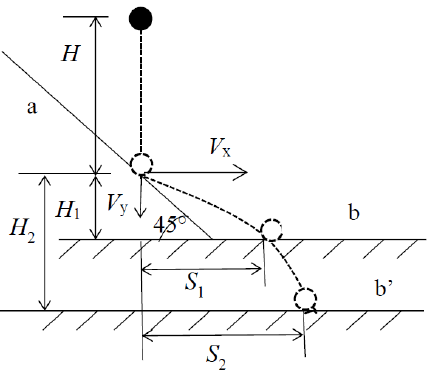
Figure 4. The experimental study on the coefficient of restitution between proppant and wall.